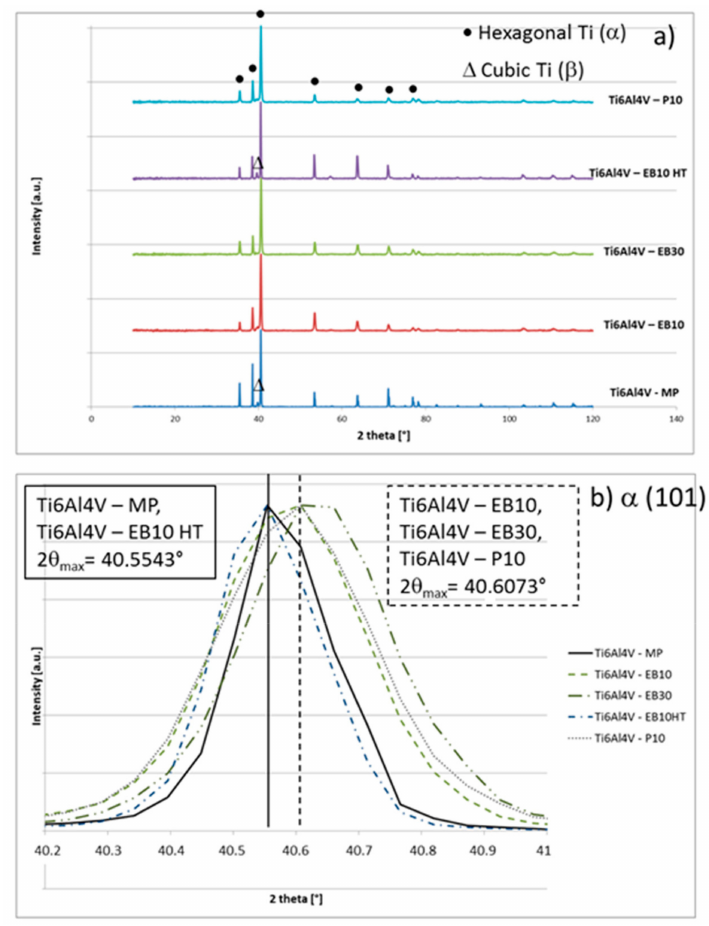
Figure 3. XRD spectra (normalized to the highest peak) ( a ) whole spectra, ( b ) detail of the highest peak. The topographical, crystallographic structural and microstructural characteristics of the samples are reported and summarized in Table